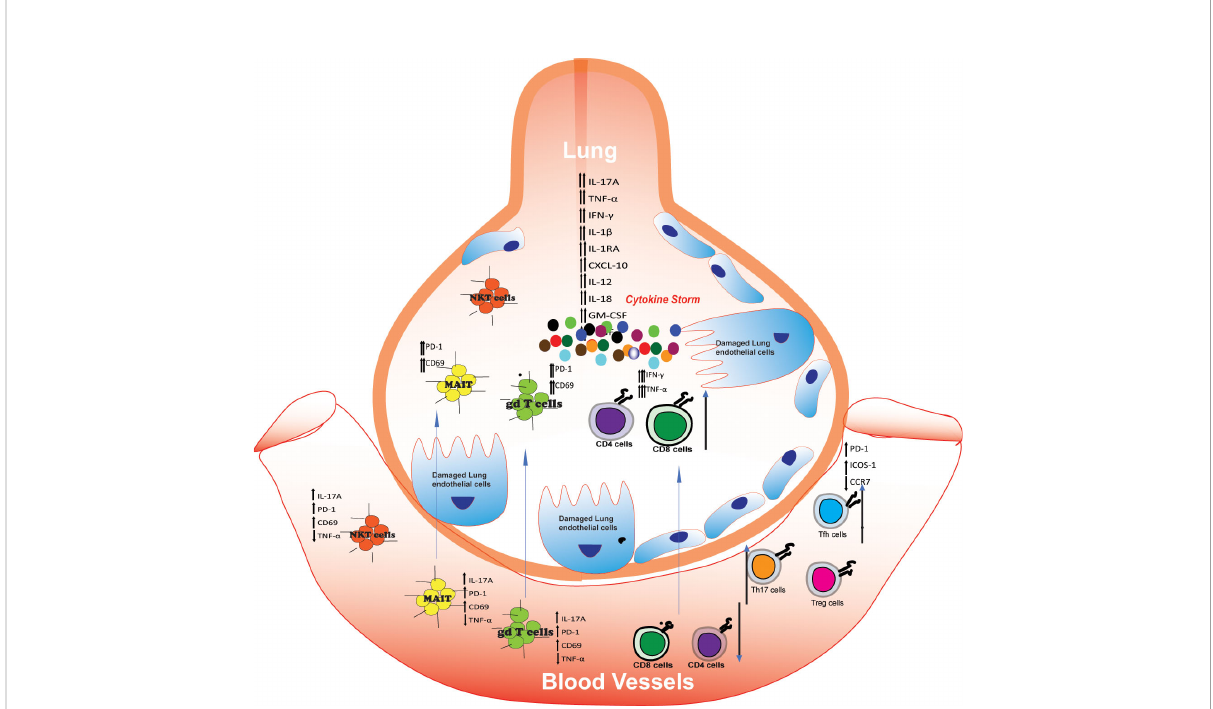
FIGURE 3 T cells in severe COVID-19: presence and activation.: Numbers of CD4 and CD8 decreased in peripheral blood (lymphopenia) while activated CD4 and CD8 cells are increased in lung secernated excessive amount of TNF- a and IFN- g which damaged lung and inhibits function of Tregs. IL-17 secreting Th17 cells and follicular helper T (Tfh) cells increased in peripheral blood of COVID-19 patients, however there are con fl icting fi nding in case of Tregs. The number of NKT, MAIT, and gd T cells decreases in peripheral blood and is detected in lung aspirates with heightened levels of activation, as evaluated by CD69 and PD-1. Activated conventional and unconventional T cells in the lung may secrete multiple in fl ammatory cytokines such as IL-17A, IL-6, TNF- a , and IFN- g that contribute to the cytokine milieu and/or disease